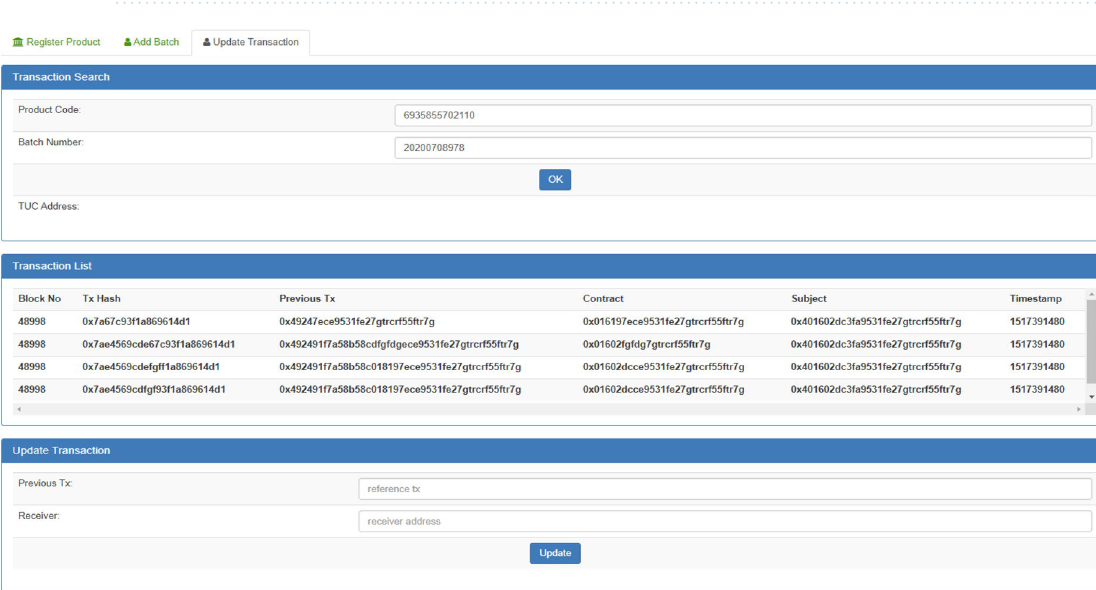
Figure 18. The blockchain transaction record and histories of the updated